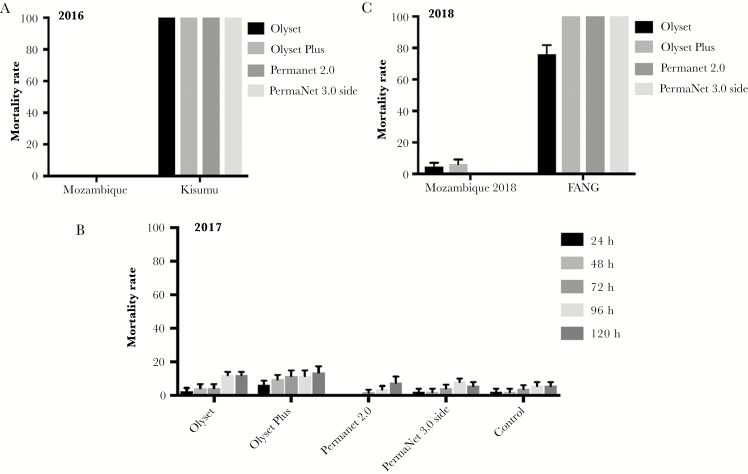
Bioefficacy of different commercial long-lasting insecticidal nets against Anopheles funestus sensu stricto in Palmeira, Mozambique, in 2016 (A), 2017 (B), and 2018 (C). Error bars represent standard error of the mean.